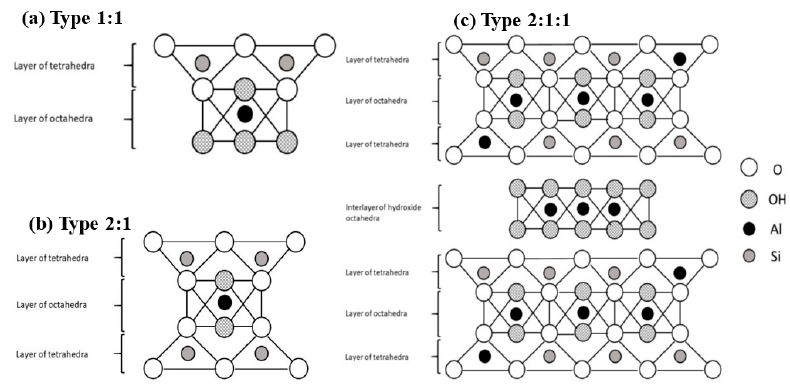
Figure 3. The layer phyllosilicate structures: ( a ) Type 1:1, ( b ) Type 2:1, and ( c ) Type 2:1:1. Reproduced with permission from Reference [39]. Open Access 2019, MDPI Animals.